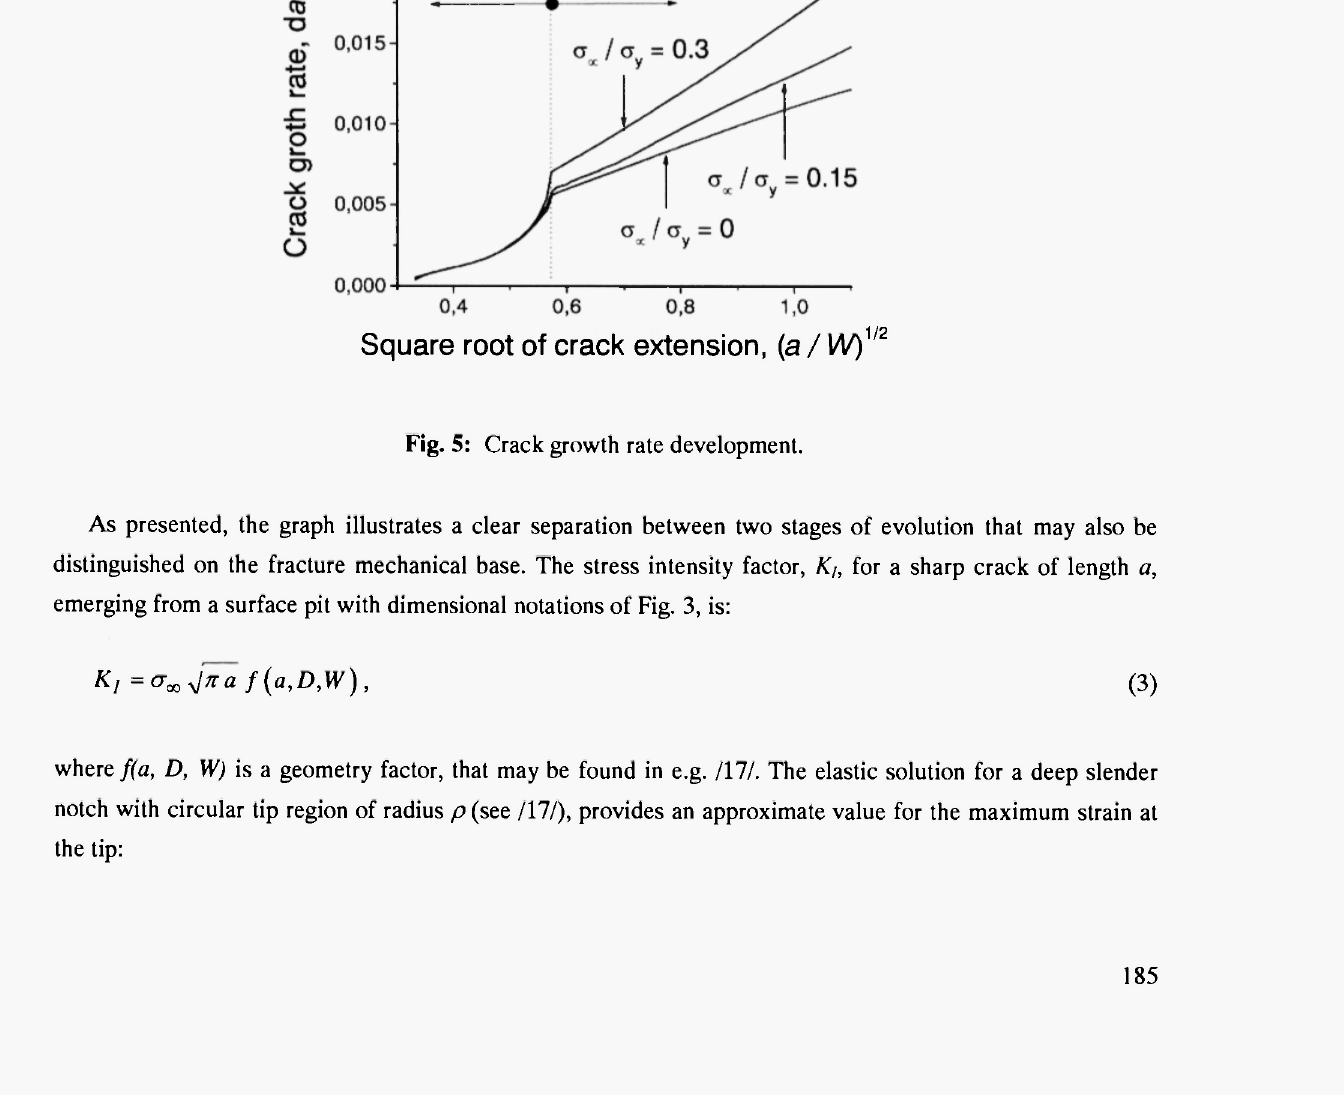
Fig. 5: Crack growth rate